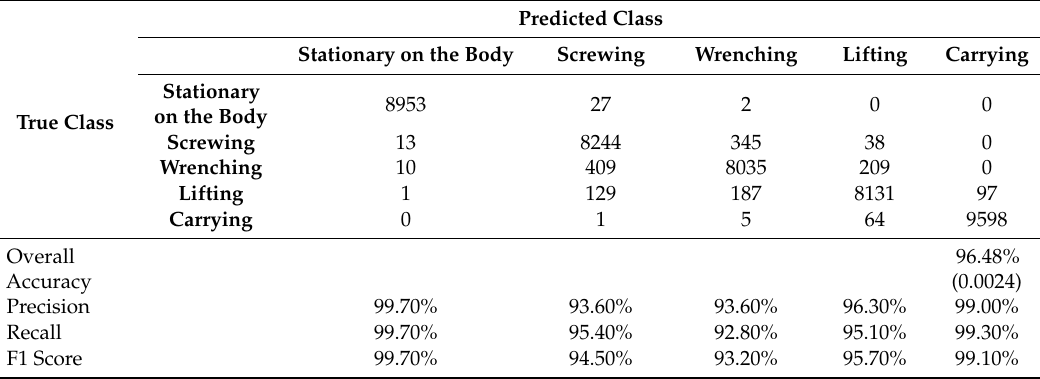
Table 11. Confusion matrix and class report of random forest classifier on Day-1